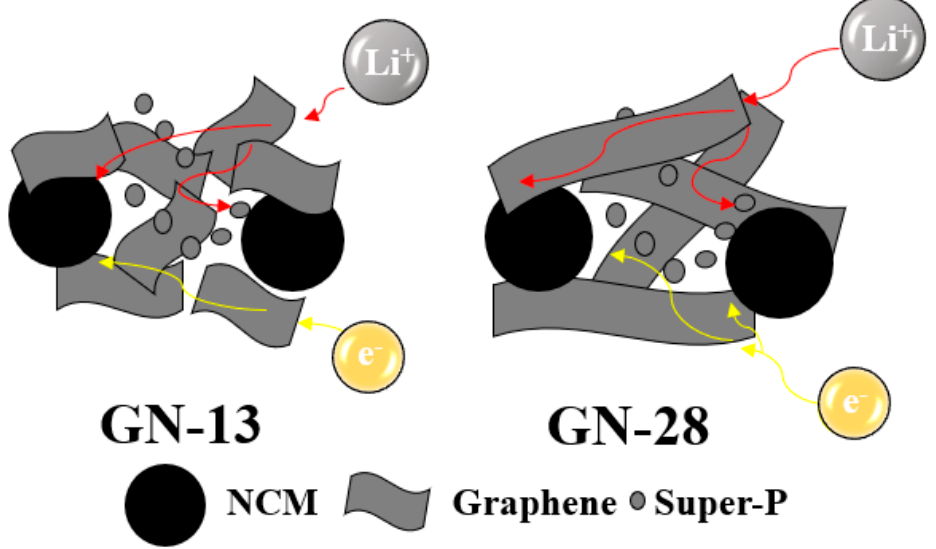
Figure 10. The schematic diagram of lithium ion and electron transport paths in different systems utilizing graphene nanosheets (GN) with different sizes and Super-P as conductive additives.